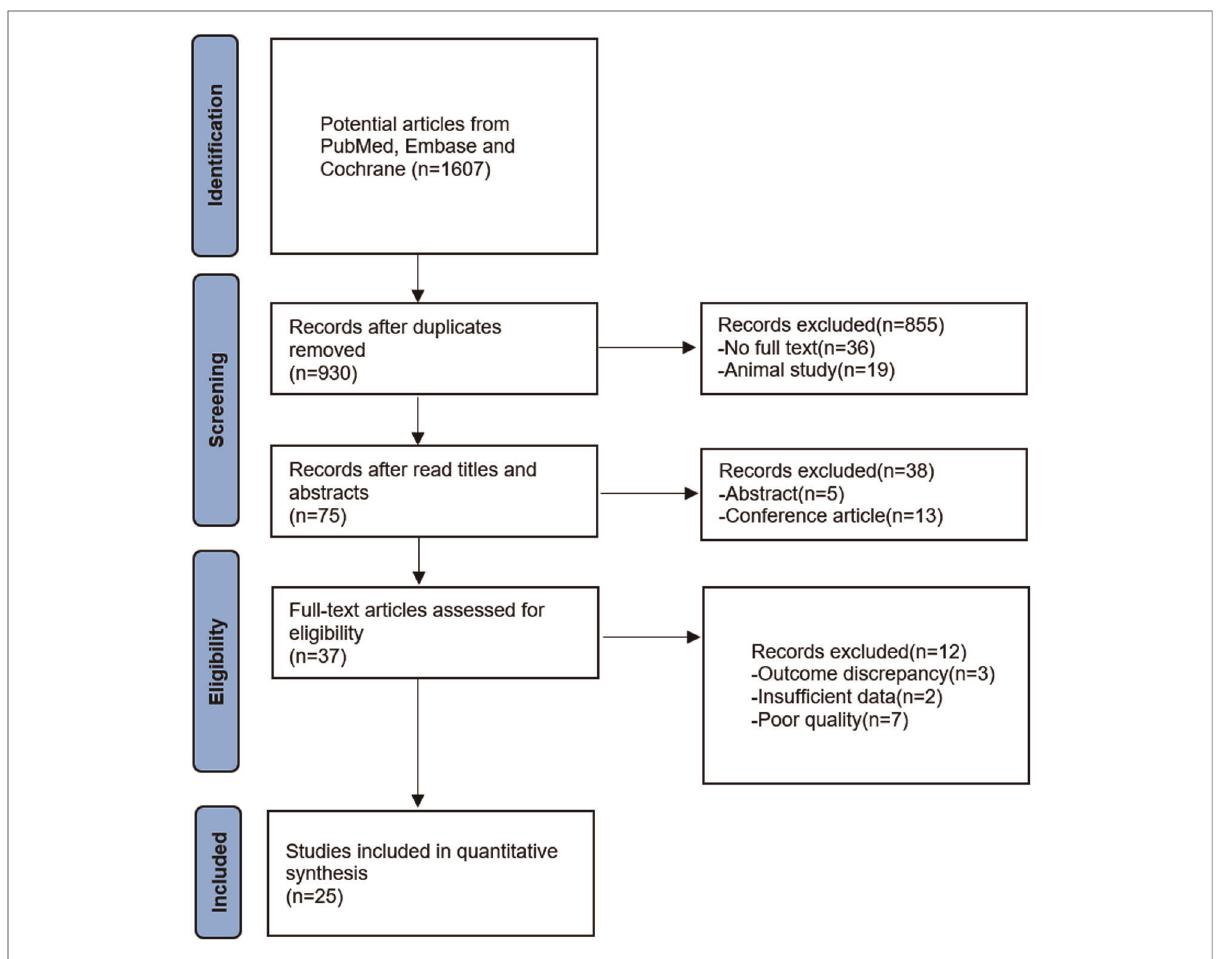
FIGURE 1 Flow chart of the literature screening process RCT, randomized controlled trial; E, experimental group; C, control group; NA, Not available; lauge- hansen Se, lauge-hansen supination external rotation type; lauge-hansen Pe, lauge-hansen pronation- eversion; RT, rehabilitation training; WB, weight bearing AOFAS scores ② VAS scores ③ total postoperative complication rates ④ DVT